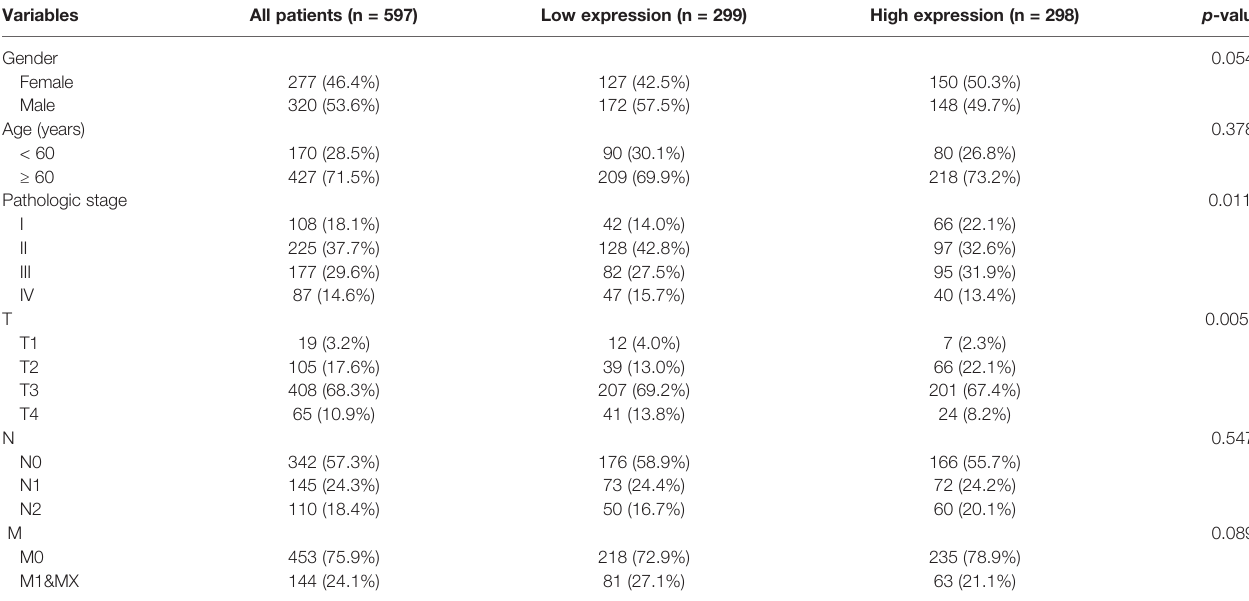
Variables All patients (n =